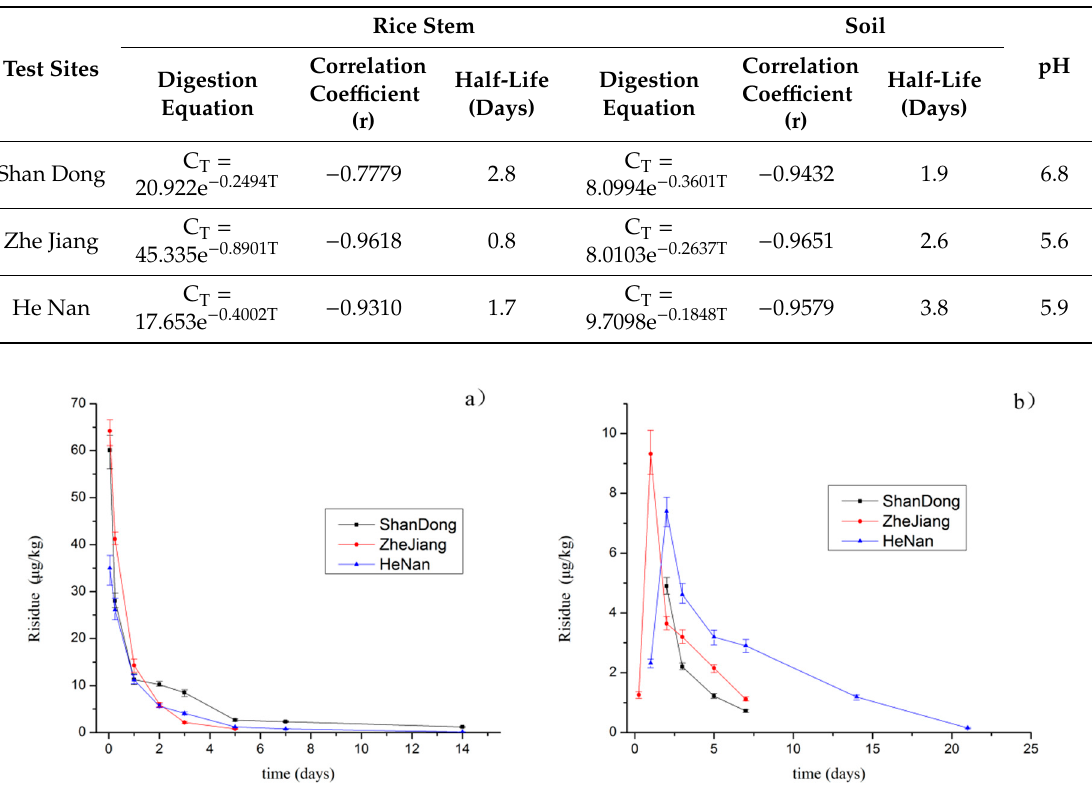
Figure 2. Dissipation curve of emamectin benzoate in rice stem ( a ) and soil ( b ). Table 3. Dynamic degradation equation of emamectin benzoate in rice stem and soil ( n = 5).